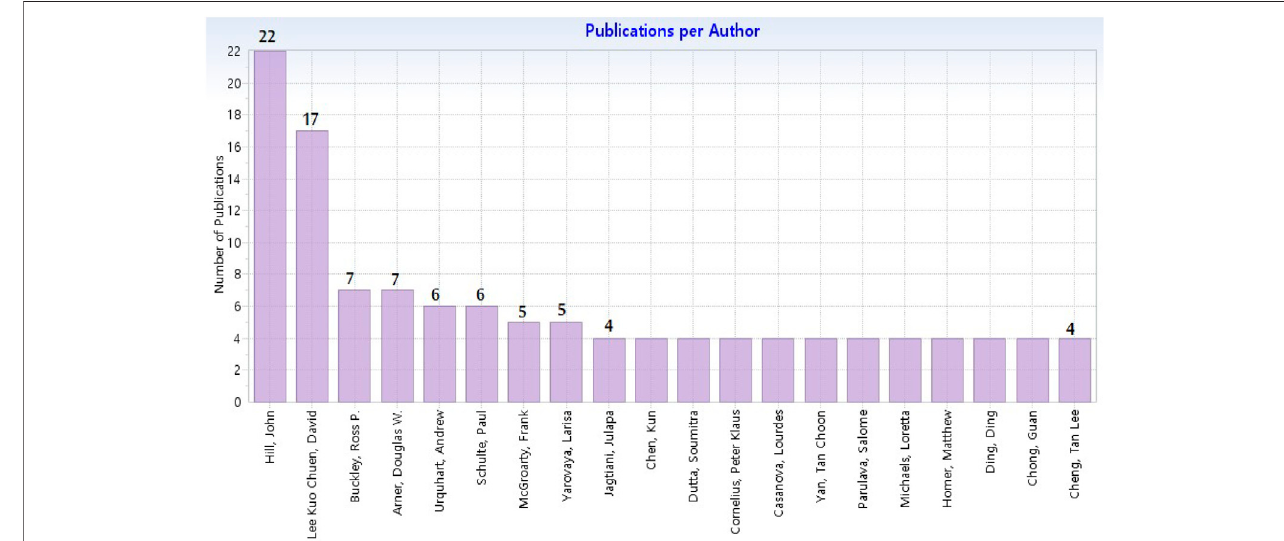
FIGURE 3 | Publications per author.